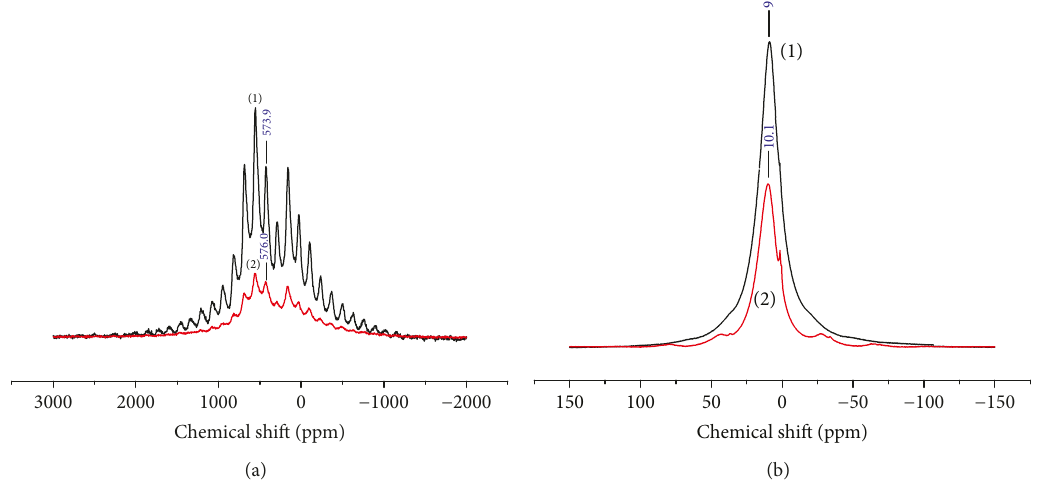
Figure 11: (a) 51 V MAS NMR spectra. Not marked signals are spinning sidebands. (b) 1 X MAS NMR spectra. (1) Initial film; (2) hydrogenated